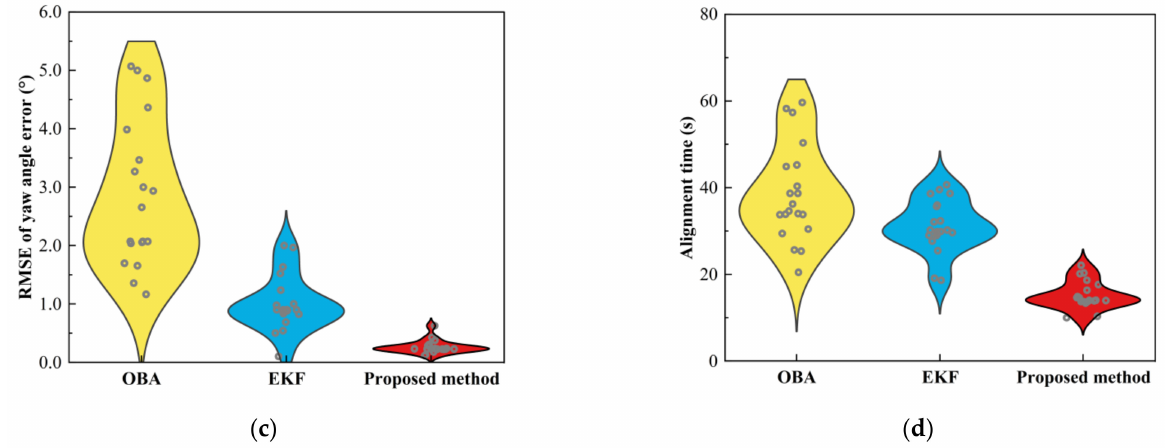
Figure 20. Comparison of alignment results obtained from three alignment methods in 20‑times re‑ peated experiments. ( a ) Violin plot for RMSE of pitch angle errors obtained from three alignment methods in 20‑times field experiments; ( b ) violin plot for RMSE of roll angle errors obtained from three alignment methods in 20‑times repeated field experiments; ( c ) violin plot for RMSE of yaw an‑ gle errors obtained from three alignment methods in 20‑times repeated field experiments; ( d ) Violin plot for alignment time of three alignment methods in 20‑times repeated field